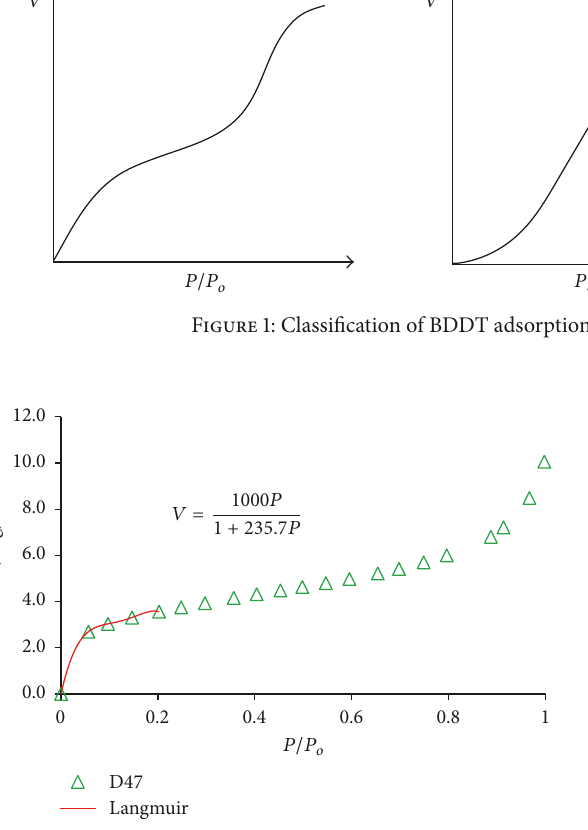
Figure 2: Application of Langmuir isotherm to nitrogen adsorption isotherm for shale at low relative pressure section.